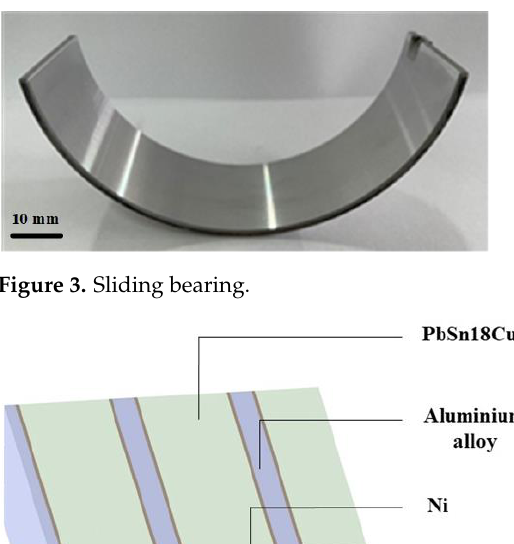
Figure 2. The component-level tribological test machine.